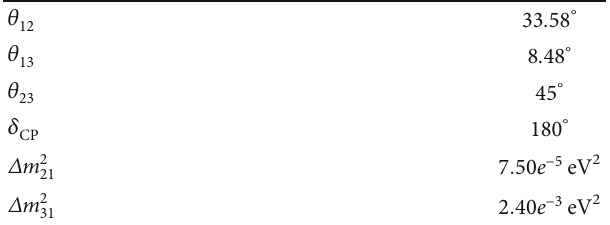
Table 1: True oscillation parameters considered in our work [27, 28].